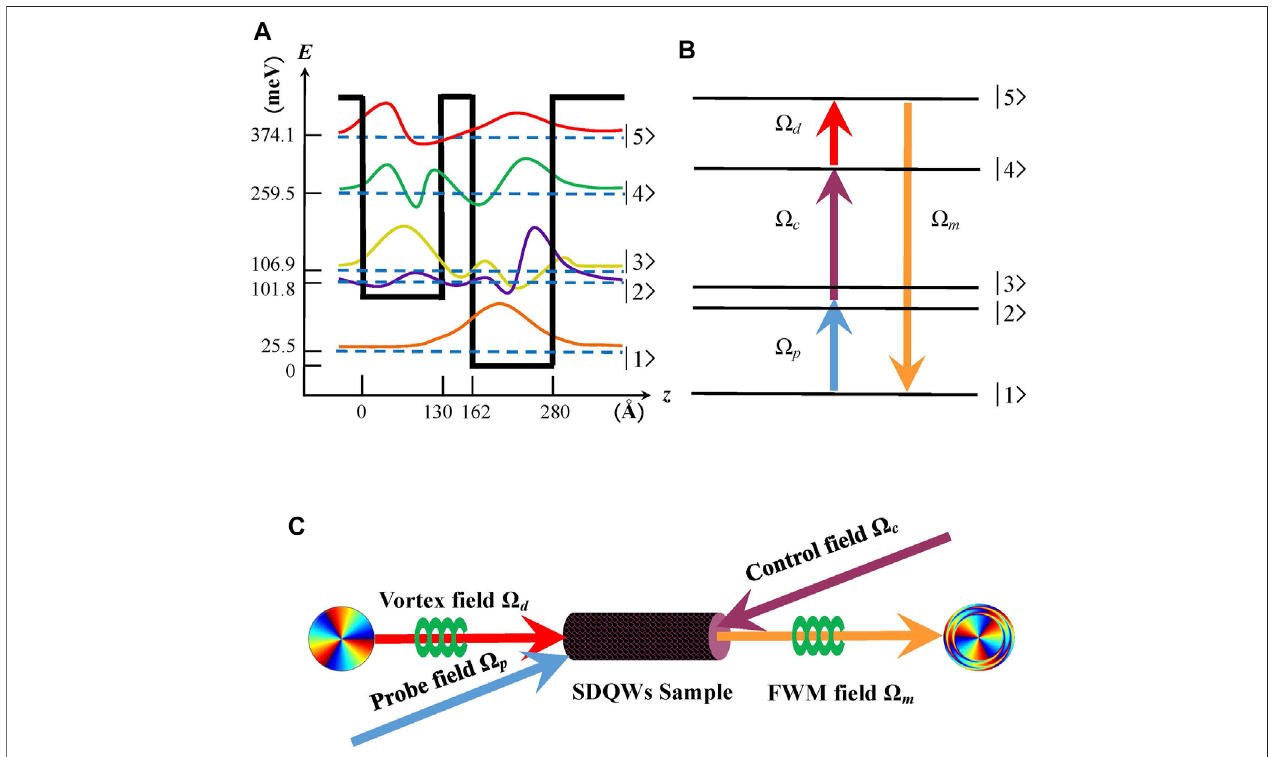
FIGURE 1 | (A,B) Schematic of diagram of an asymmetric SDQW nanostructure with fi ve subbands. The solid curves represent the schematics of the correspondingelectronicwavefunctions. (C) AsimpleblockdiagramoftheSDQWnanostructuresamplewithfouroptical fi elds,inwhichthedriving fi eldisaPOVbeam.